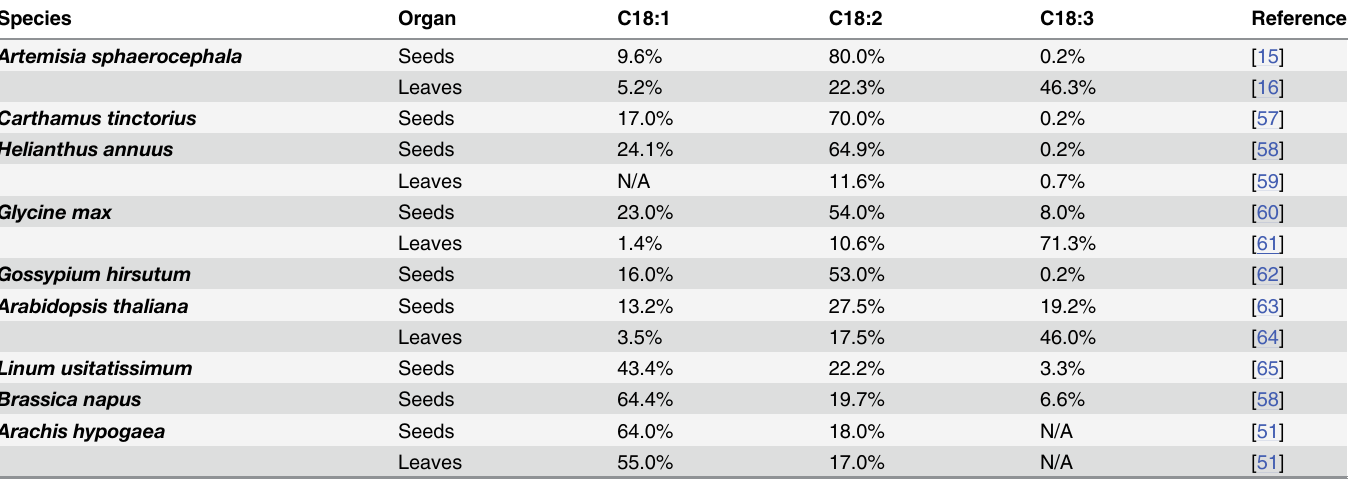
Table 5. Fatty acid compositions of different species.